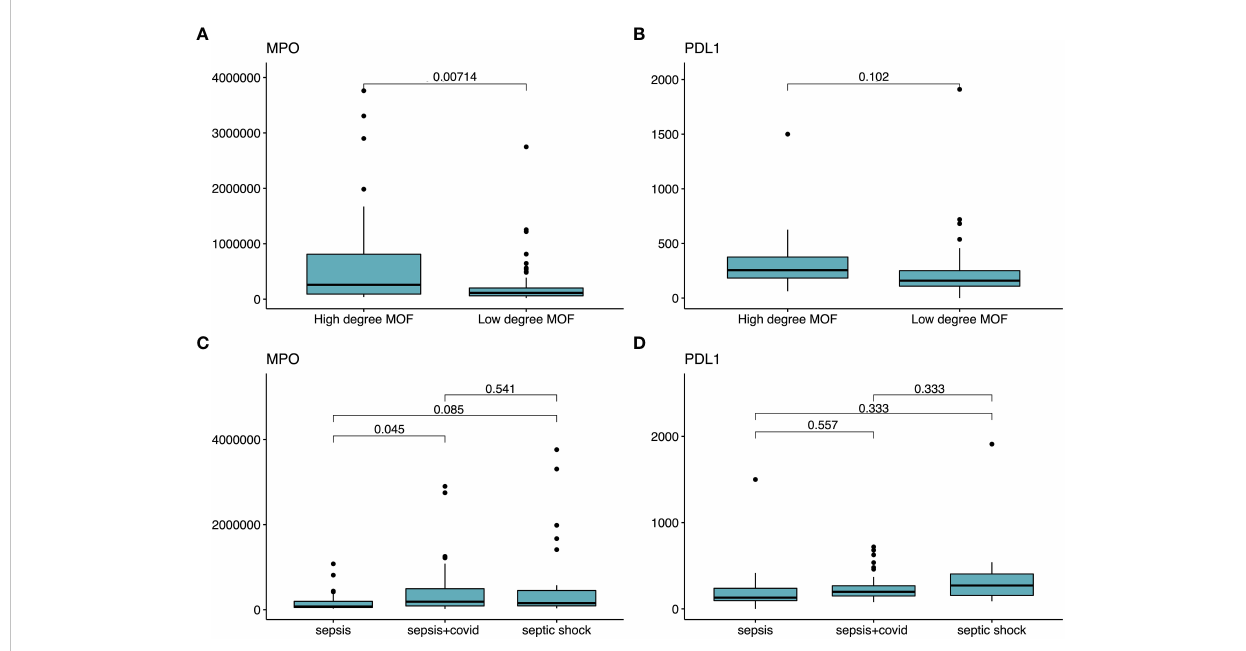
FIGURE 6 Statistical tests employed for PDL1 and MPO as characterizers of severity and disease model. Statistical signi fi cance tests comparing the averages of different groups of patients. In (A, B) , we show the mean comparison of MPO and PDL1 (respectively) in distinguishing each one of the target labels (i.e., HDMOF and LDMOF). In (C, D) , we employ the mean concentration MPO and PDL1 (respectively) in distinguishing sepsis, sepsis COVID, and septic